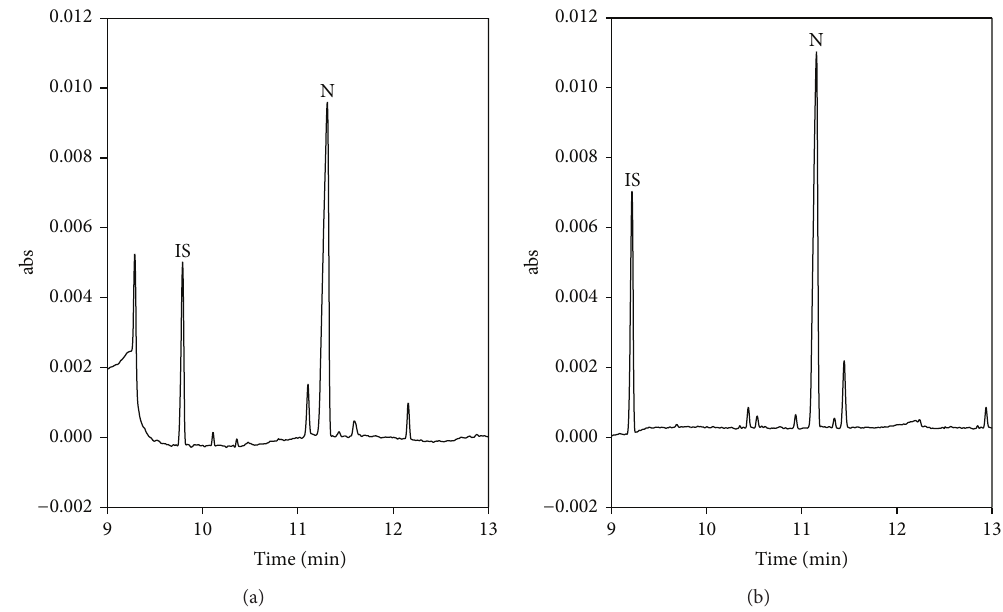
Figure 4: Electropherograms for determining nicotine (standard solution) under optimized conditions (a) and tobacco sample I (b). CE conditions: separation buffer: 50 mM phosphate buffer (pH 3) containing 25% methanol; sweeping buffer: 50mM phosphate buffer (pH 3) containing 20% methanol and 50 mM SDS; HCB: 160mM phosphate buffer (pH 3); applied voltage, − 25 kV. Sample injection: 15kV, 15